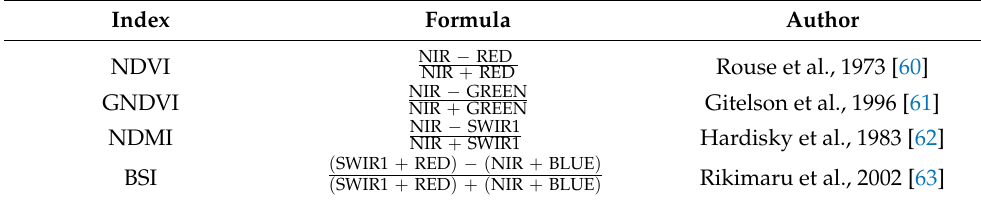
Table 3. Spectral indices and related formulas used in the